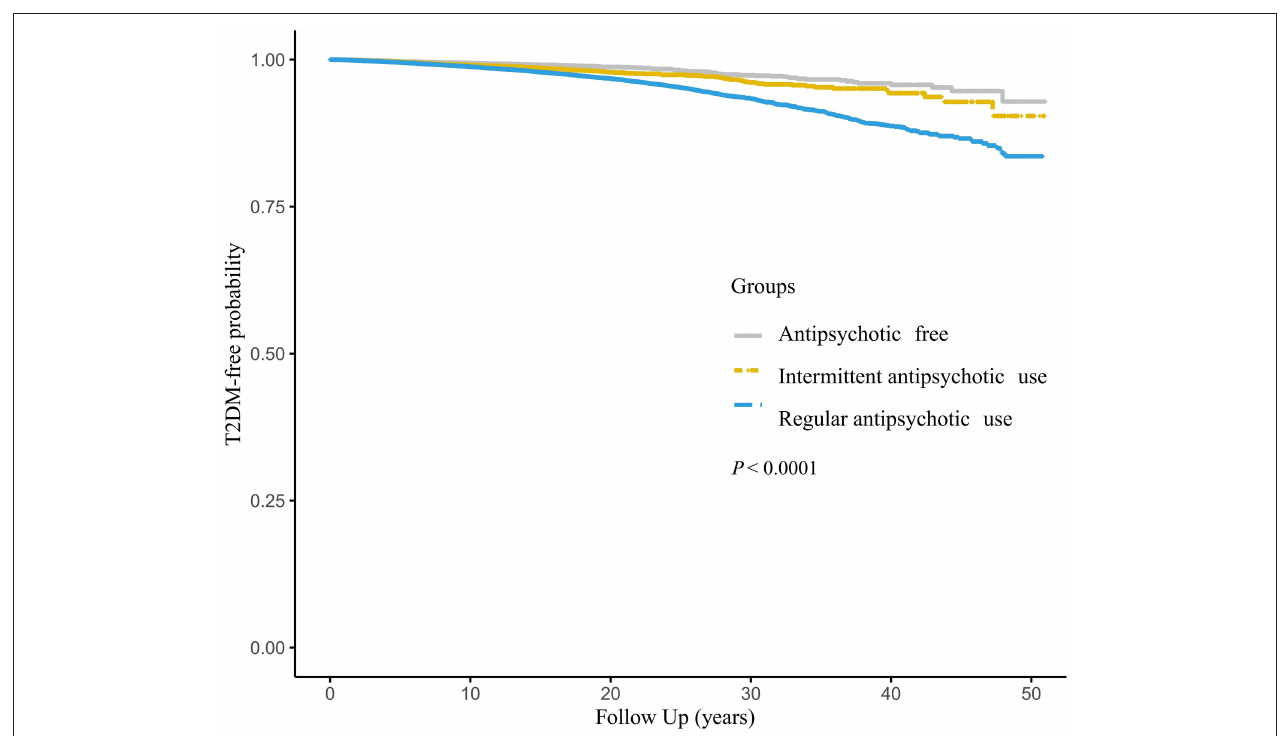
FIGURE 2 | Kaplan–Meier analysis of T2DM by antipsychotic use. T2DM, type 2 diabetes